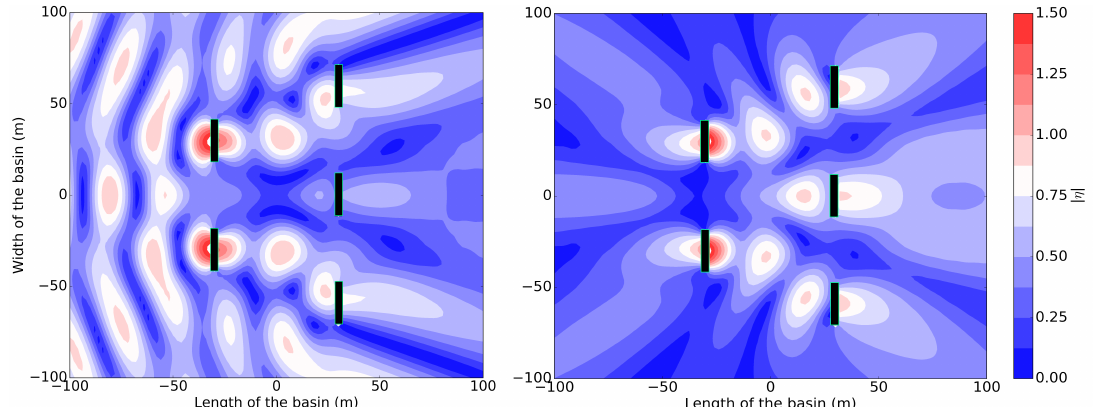
Figure 17. The total ( left ) and perturbed ( right ) | η | for an array of heaving cylindrical WECs for a wave of H = 1.0 m, T = 6.0 s for a linear PTO system. Incident wave propagating from the